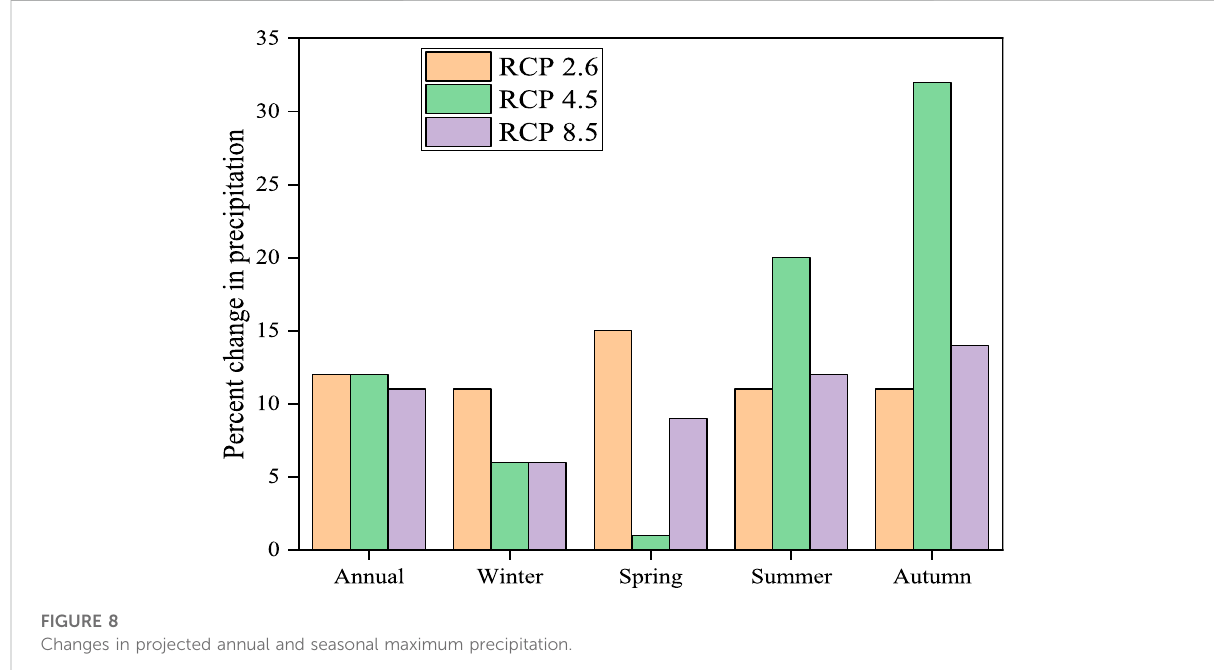
FIGURE 8 Changes in projected annual and seasonal maximum precipitation.